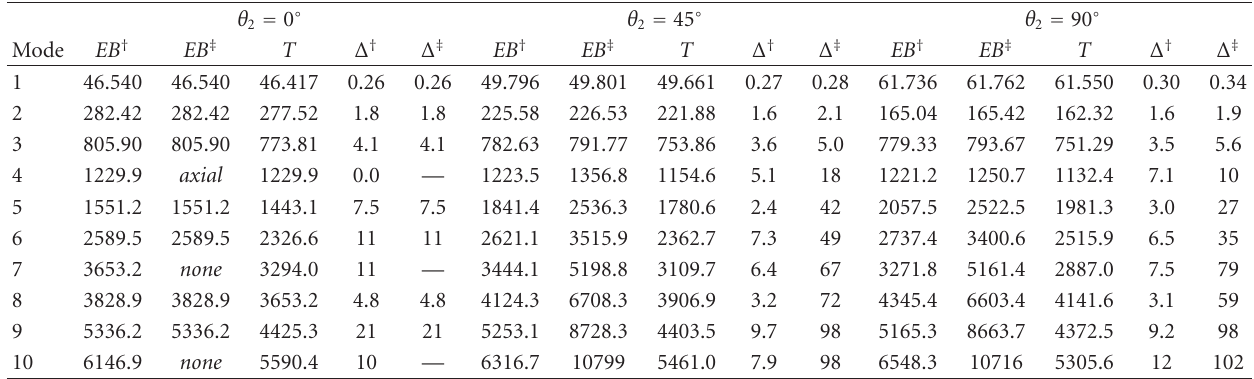
Table 6: First ten natural frequencies (Hz); two-link manipulator; ( L 1 /h = 8 . 33, L T /h = 17 .